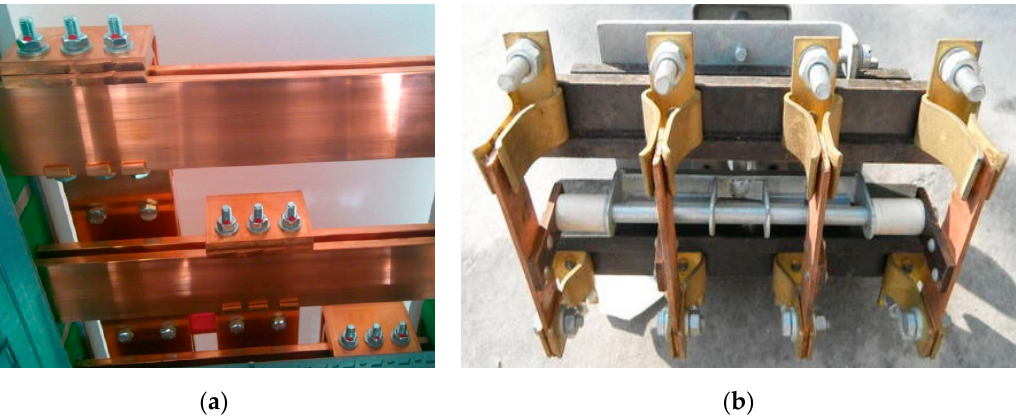
Figure 1. The view of exemplary contacts from families: ( a ) Non-connecting contacts (own study) and ( b ) connecting contacts [23].